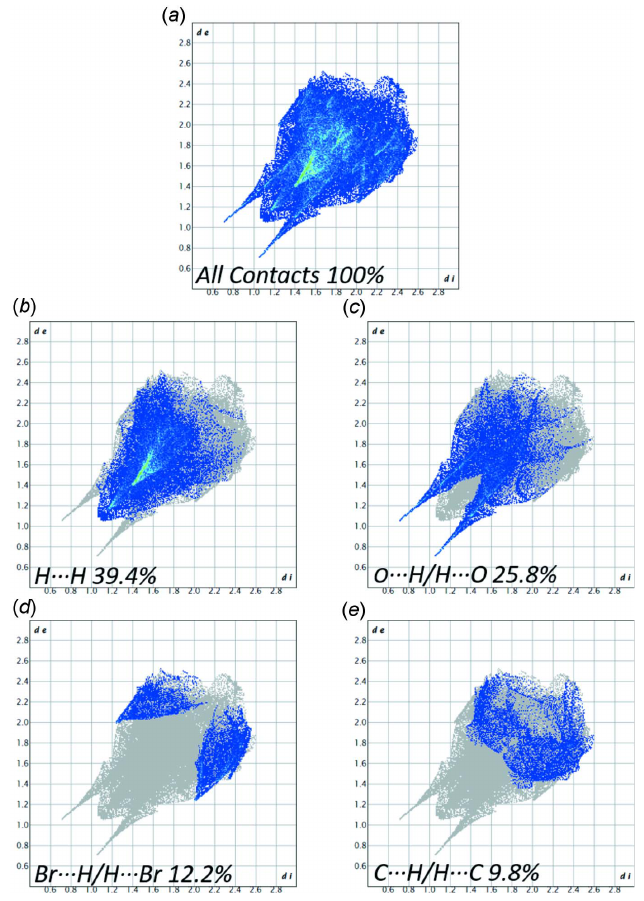
Figure 4 Hirshfeld surface of 4-bromo- N -(propylcarbamoyl)benzenesulfonamide mapped over d norm , displays close contacts in the crystal. The non- covalent interactions indicated by the red spots are labeled.